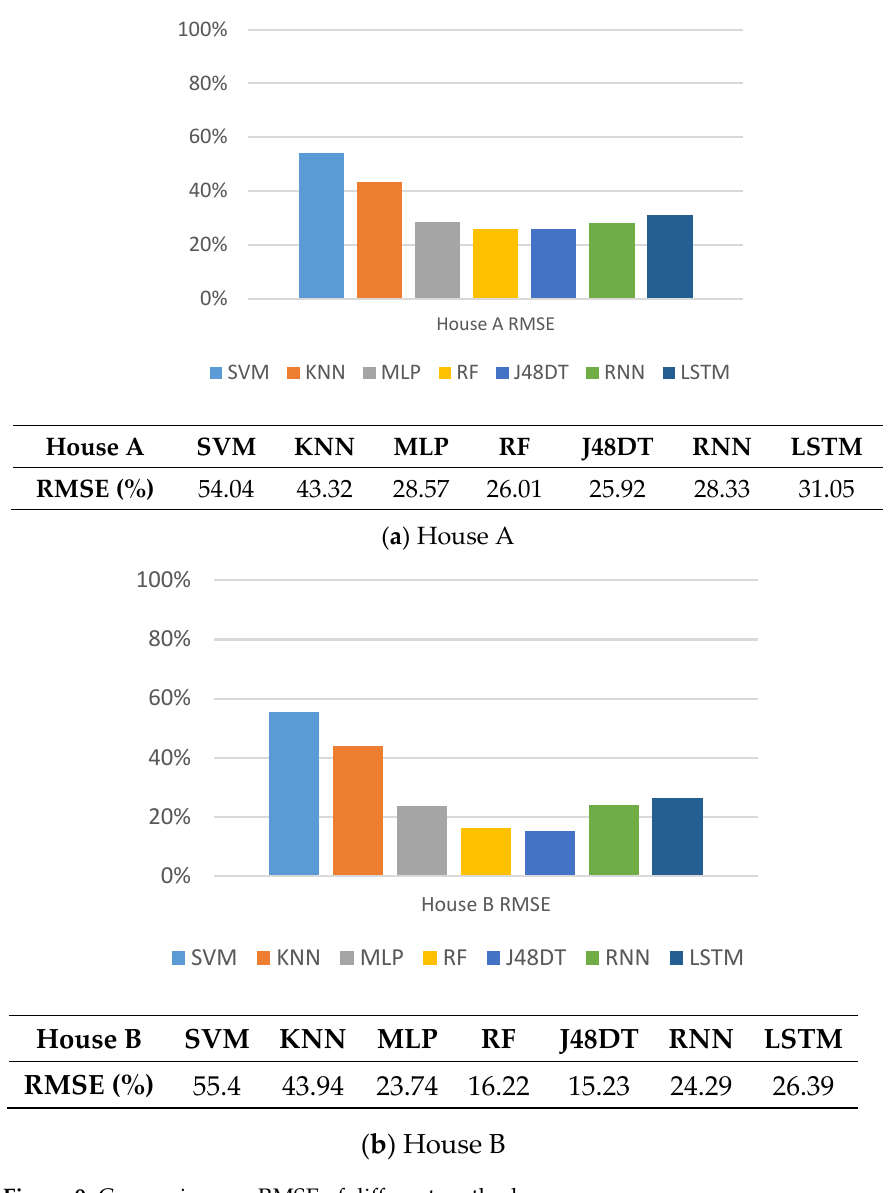
Figure 9. Comparison on RMSE of different methods.